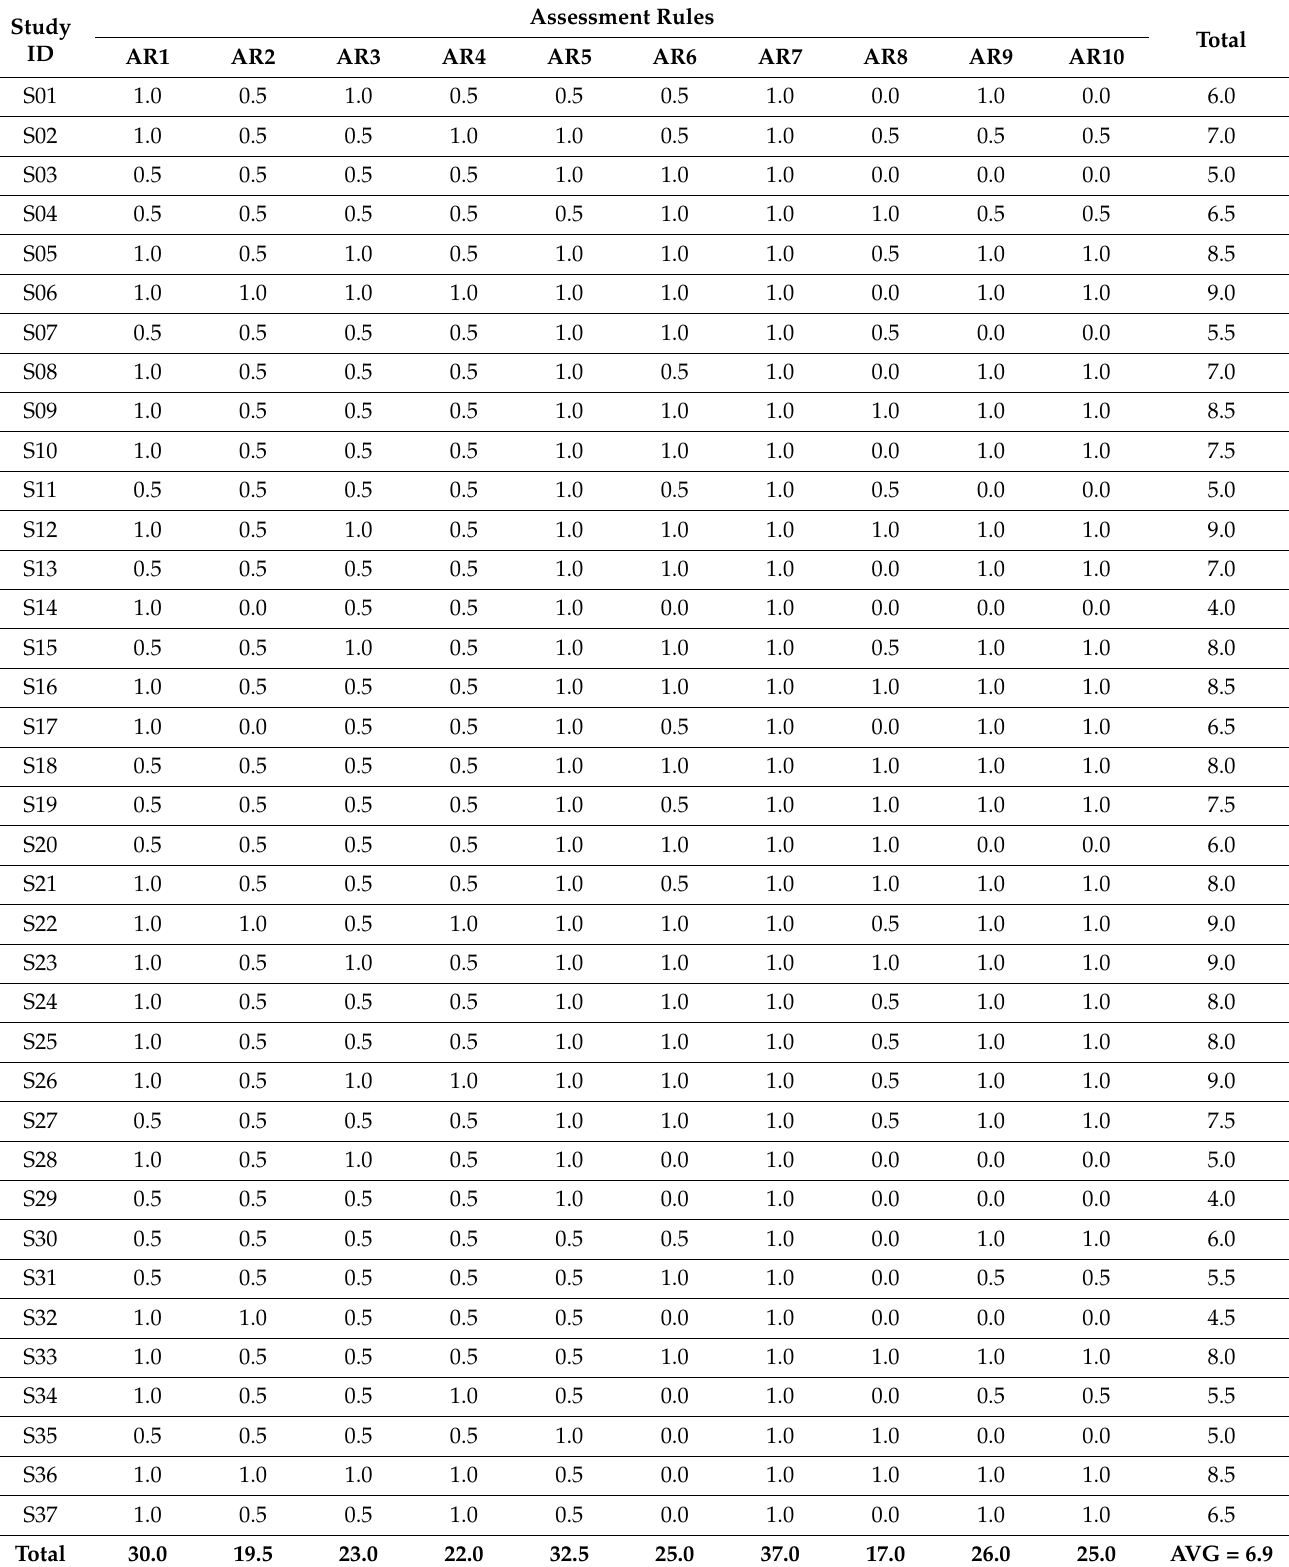
Table 7. Assessment scores for selected studies (1 = fully answered, 0.5 = partially answered and 0 = not